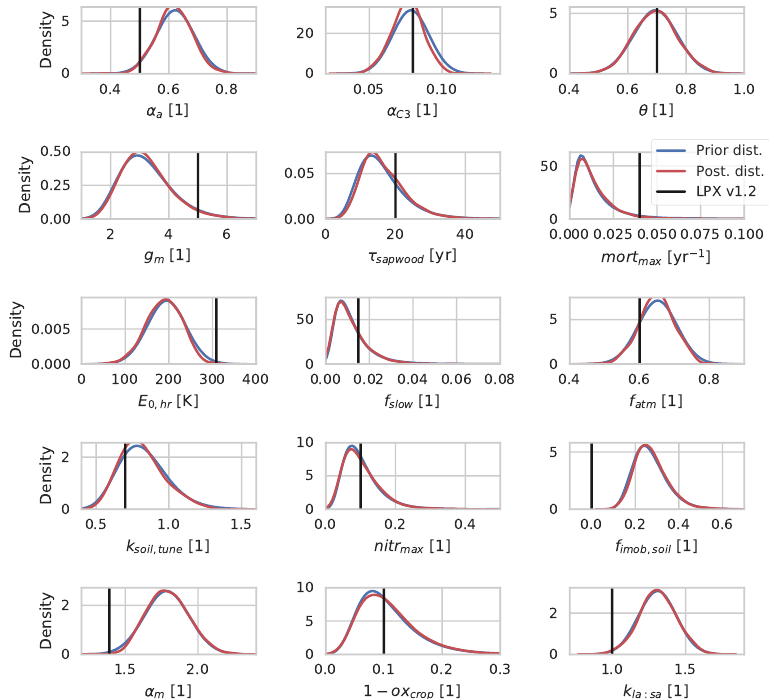
Figure 1. Kernel density estimations of the prior probability distribution (blue) and the posterior probability distribution (red) of the con- strained ensemble with net land use ( M net , net ). The prior distribution was improved iteratively, resulting in near convergence of prior and posterior distribution. Vertical black bars indicate the parameter values used in LPX-Bern